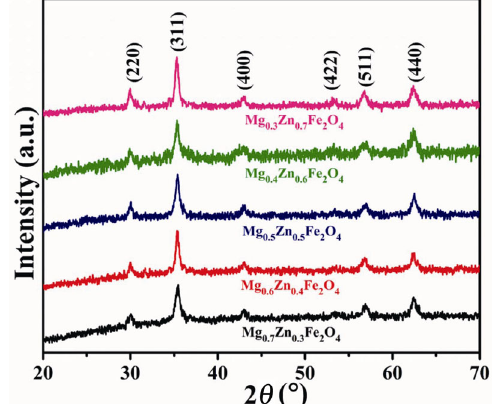
Fig. 1 XRD patterns for Mg 1– x Zn x Fe 2 O 4 ( x = 0.3, 0.4, 0.5, 0.6, and 0.7) NPs. Cation distribution, a exp , and D